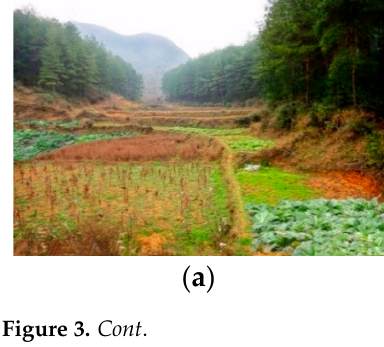
Figure 2. Relationship between spatial objects and rights.